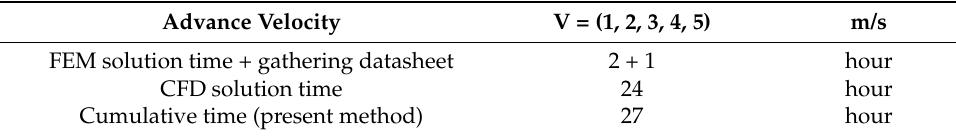
Table 10. The time needed to analyze different